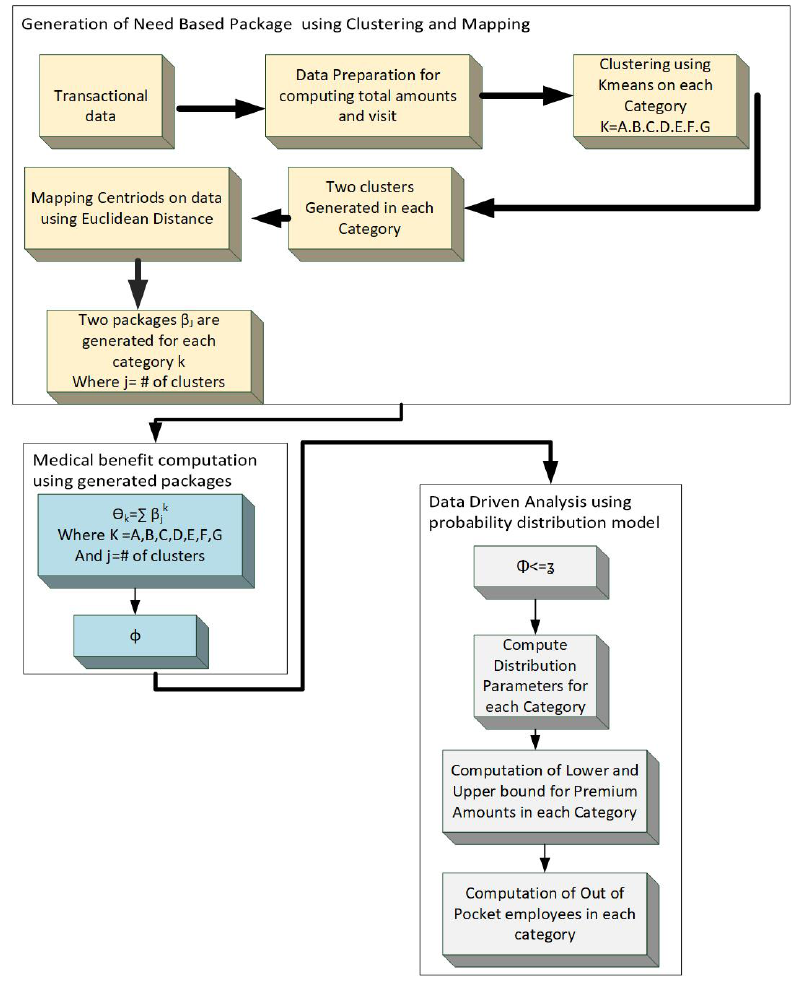
Figure 2. Graphical Summary of Proposed Methodology.